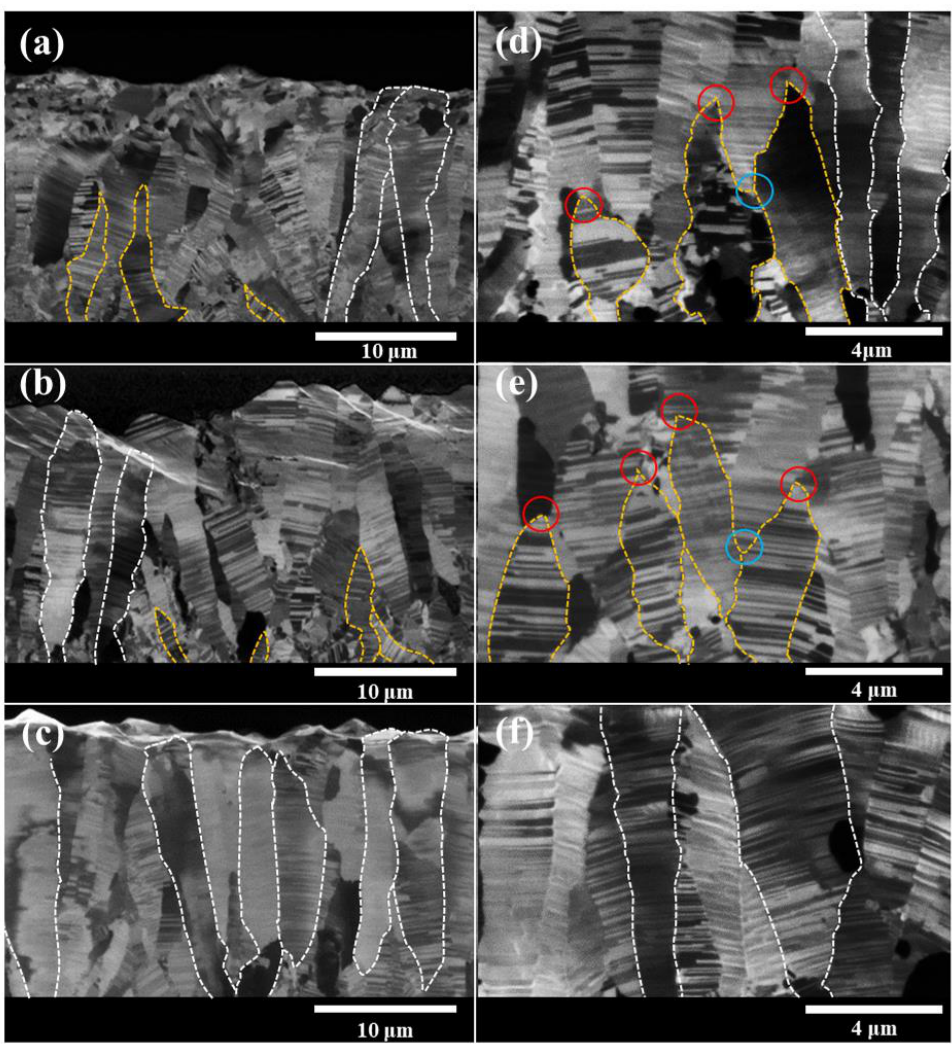
Figure 1. FIB cross-sectional images of the electroplated nt-Cu films. Images ( a – c ) are the low-magnification FIB images corresponding to the nt-Cu films electroplated with the Cu-sulfate base plating solution added with the concentration of gelatin (8 g/L), (7.9 g/L), and (7.8 g/L), respectively. Images ( d – f ) are the high-magnification FIB images relative to ( a – c ). Figure 2 is the bright-field TEM image showing the microstructure of twin grain With the low-magnification FIB images shown in Figure 1a–c, the important parame- structure of the nt-Cu film plated with the concentration of 7.8 g/L gelatin. Clearly, the ters for the microstructure of the twin grains in the nt-Cu films, such as the spacing and the density of the twin boundary in the Cu columnar grains, can be calculated. The lamellar granular structure can be seen in the bright-field TEM image. In the study of twin grains, people define the lamellar grains with alternativ e “twin” lamellar grain and “ma- trix” lamellar grain [ 10,36 – 37 ]. As seen in Figure 2, the “twin” lamellar grain is delineated with a yellow dashed line and the “matrix” lamellar grain is delineated with a white dashed line. TEM selected area diffraction was performed at the interface (indicated with a red circle with a diameter of 100 nm). Therefore, it means that TEM selected area diffrac- tion would include both twin lamellar grain and matrix lamellar grain. The zone axis of the selected area diffraction is <110>. As shown in the right-corner insert, i.e., TEM selected area diffraction pattern, two sets of reciprocal lattices with a mirror-symmetrical can be observed. In the selected area diffraction pattern, white-color spots belong to the matrix lamellar grain, which are corresponding to (11̅1) , (1̅11) , (1̅11̅) , and (11̅1̅) . Moreover, the yellow-color spots belong to the twin lamellar grain, which are corresponding to (111̅) T , (1̅11) T , (1̅1̅1) T , and (11̅1̅) T . The result of TEM selected area diffraction pattern suggests that the twin grains in the present electroplated nt-Cu films grew preferentially on the {111} plane family. The coincident sites boundary index, Σ, specifies the coherence